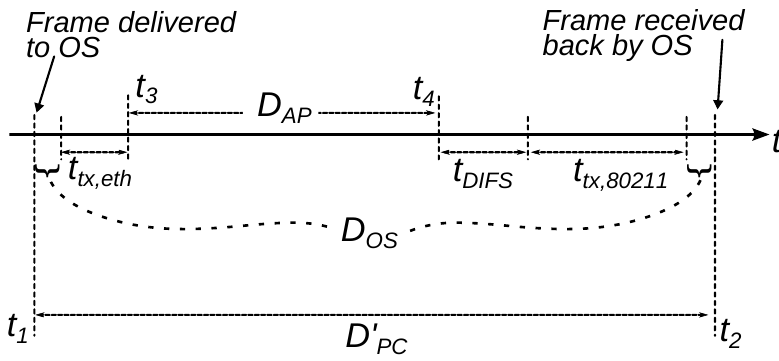
Figure 4. A schematic representation of the different terms of delay that are measured by the traffic generator, and are included in D (cid:48) PC